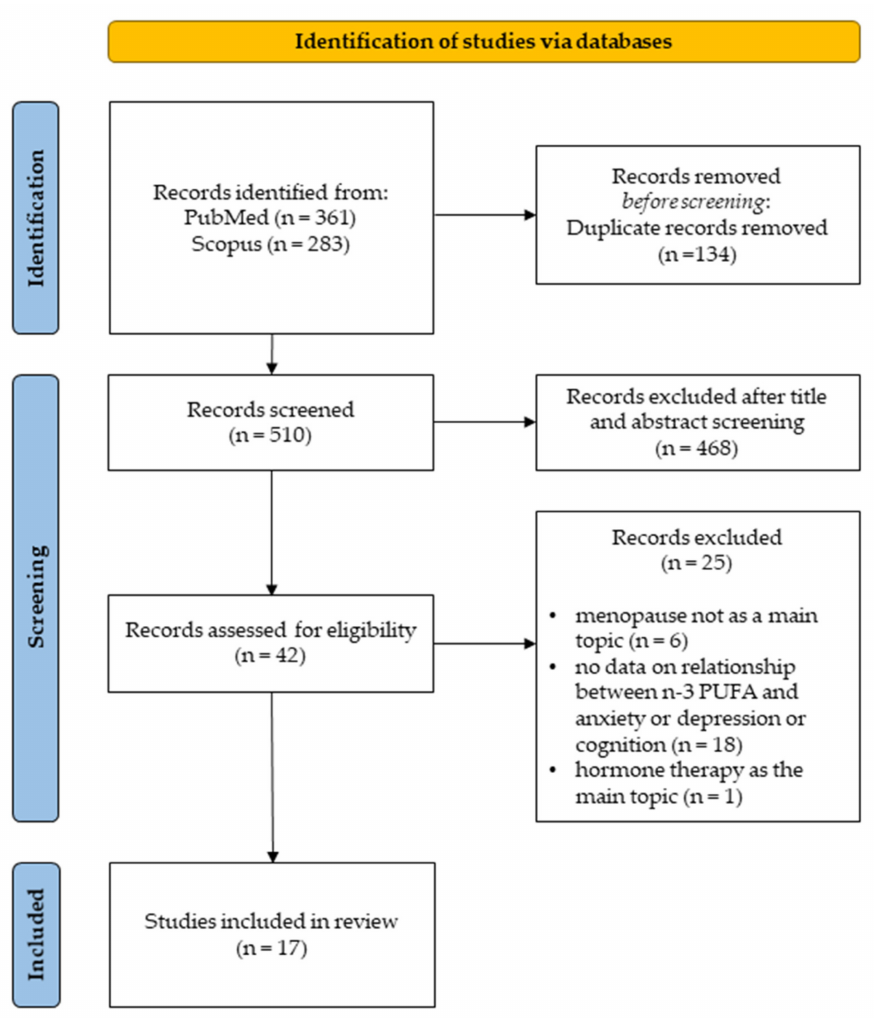
Figure 2. Search flow diagram based on PRIMA